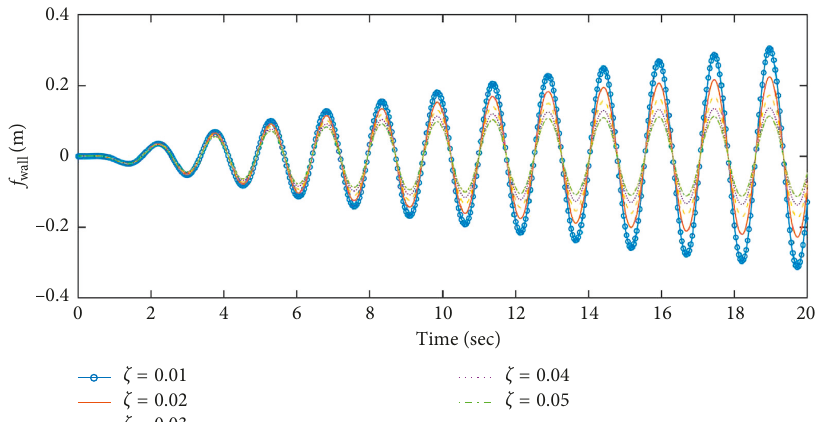
Figure 15: The resonant time histories of the surface wave height on the wall ( θ � 0) for z